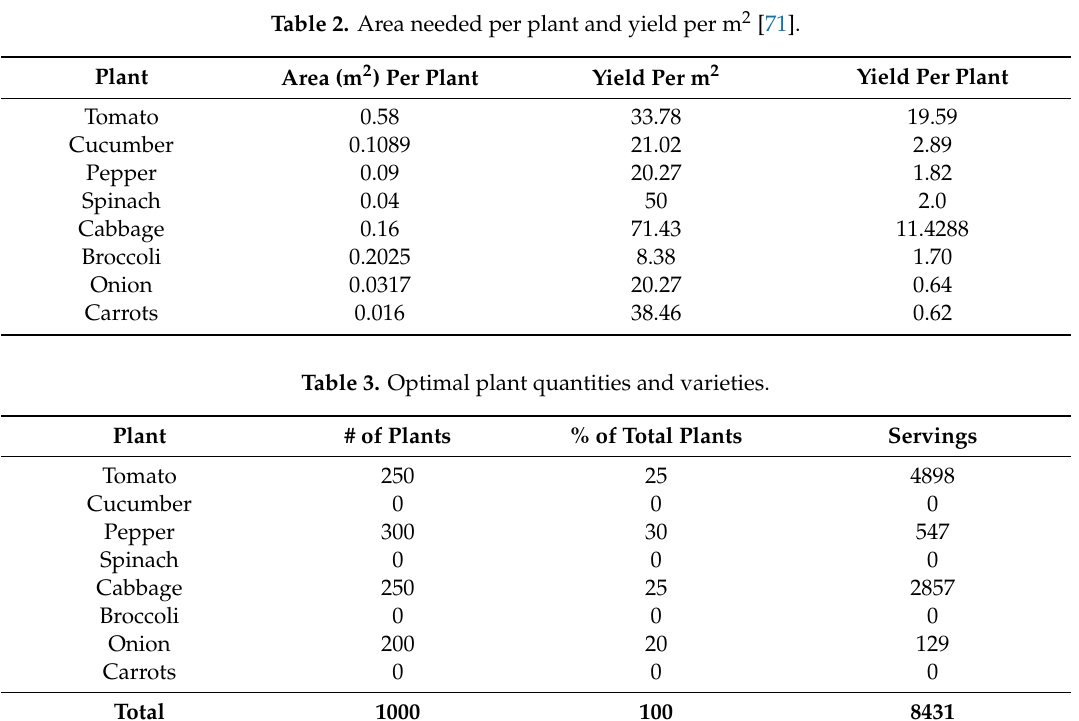
Table 2. Area needed per plant and yield per m 2 [71].